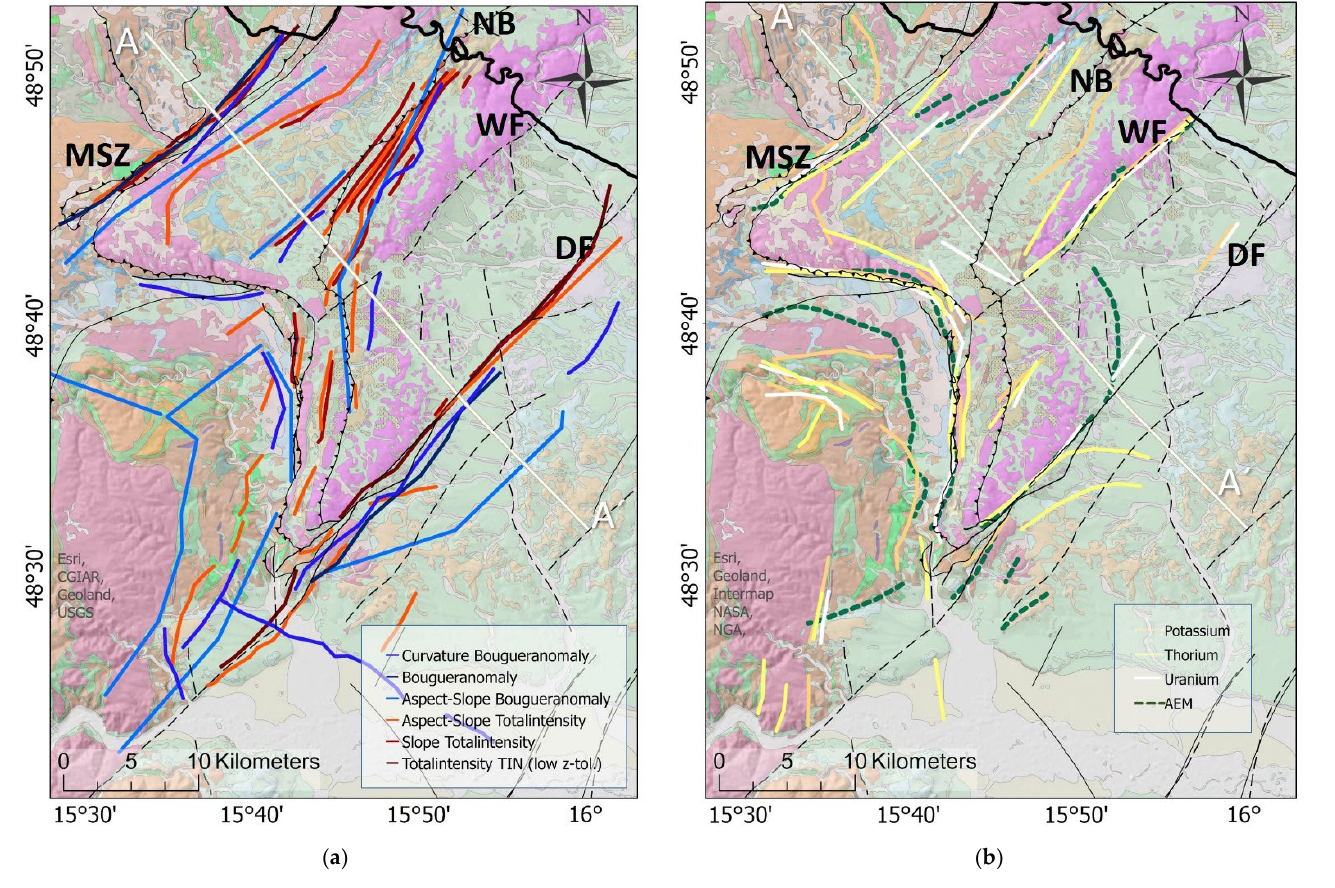
Figure 10. ( a ) Compilation of all visually derived lineaments extracted from geophysical data relying on deeper sources: gravity, magnetic, and electromagnetic data. ( b ) Compilation of all visually derived lineaments extracted from data relying on shallow sources: radiometric and electromagnetic data. In the background of both ( a , b ), a section of the 1:200.000 geological map of Lower Austria at the scale of 1:200.000, reprinted with permission from [15,16], Geological Survey of Austria (GBA), 2002. is shown to indicate the mapped changes in lithology.